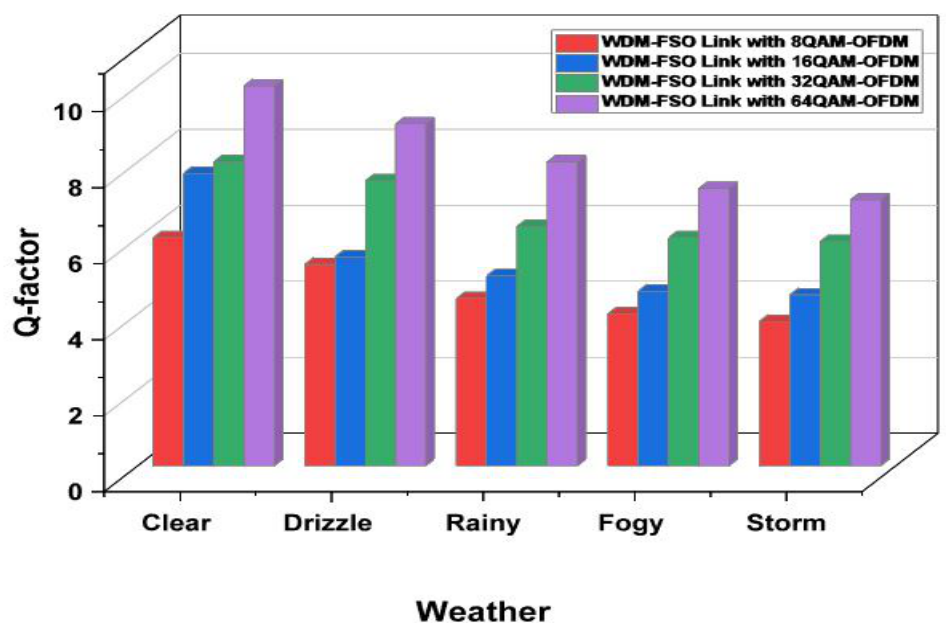
Figure 4. Weather conditions vs. Q-factor simulation investigations for different modulation formats.